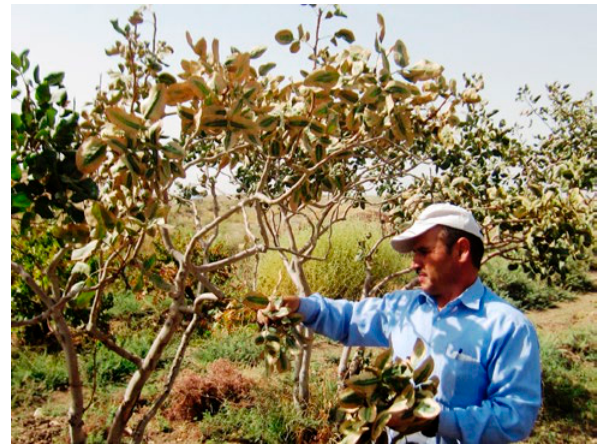
Figure 1. Pistachio tree with leaf scorch symptoms on a branch, caused by Xylella fastidiosa